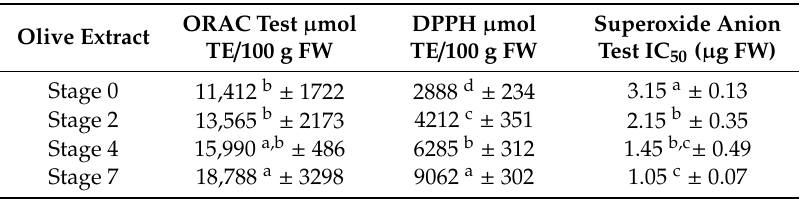
Table 3. Antioxidant activity detected in extracts of Cellina di Nard ò olives at four di ff erent maturation stages. Results are expressed as µ mol Trolox Equivalents / 100 g FW (ORAC and DPPH tests) and as Inibitory Concentration (IC 50 , µ g of FW olive pulp). Same letters indicate no statistical di ff erences between averages (Duncan test, n = 3, p =